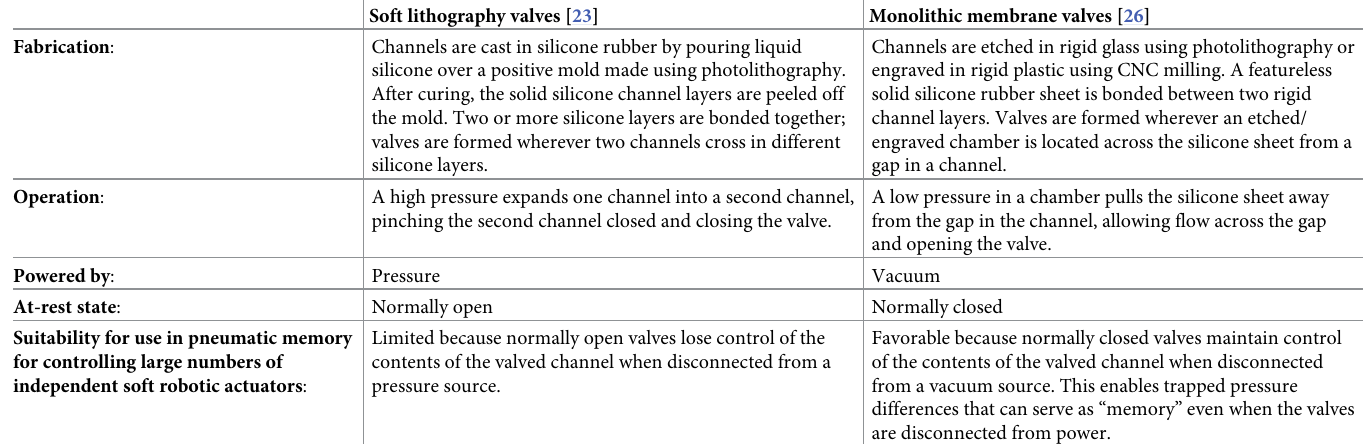
Table 1. Comparisons between soft lithography valves (used in most previous work on microfabricated pneumatic logic control of soft robots) and monolithic mem- brane valves (adapted for use in this work).